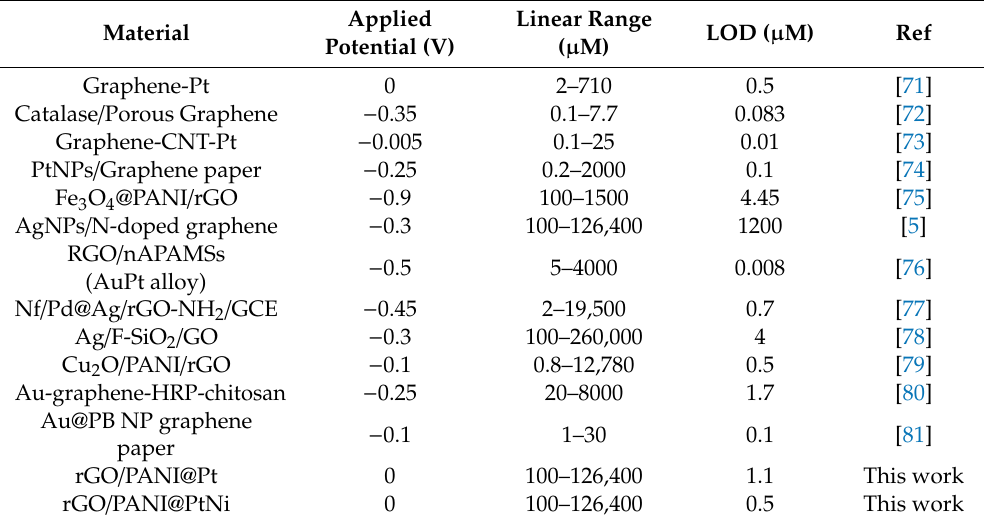
Table 2. Comparison of the electrochemical performance of H 2 O 2 sensors based on the graphene